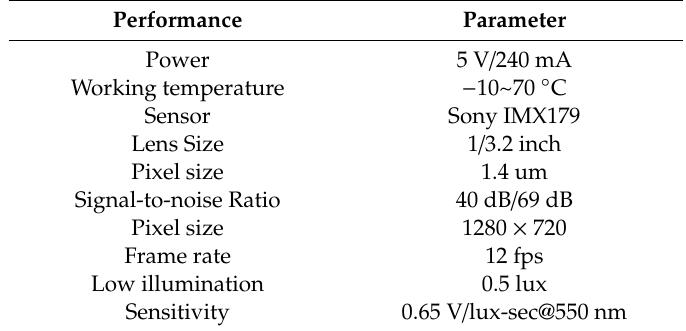
Table 2. The performance parameters of the camera.